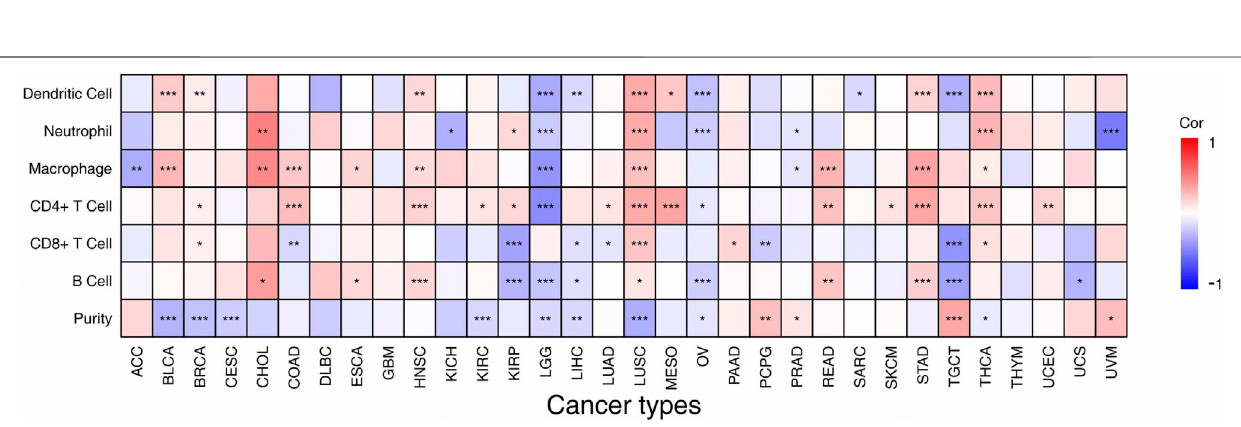
FIGURE 6 | Association between VSTM2L expression level and abundance of TIICs in different cancer types in TIMER, shown as a purity-corrected partial Spearman ’ s rho value. * P adjusted < .05, ** P adjusted < .01, *** P adjusted < .001.